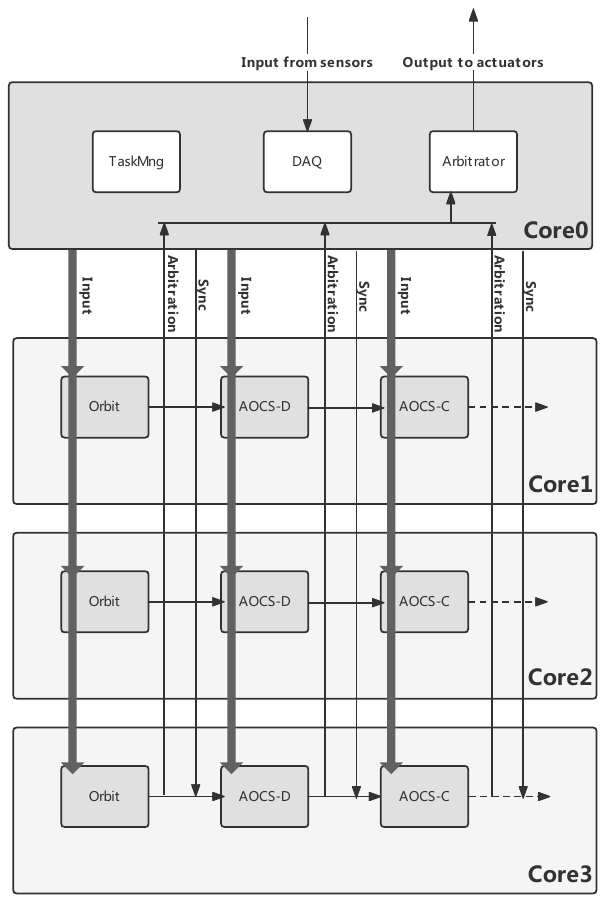
Figure 6. Triplication-redundancy mode